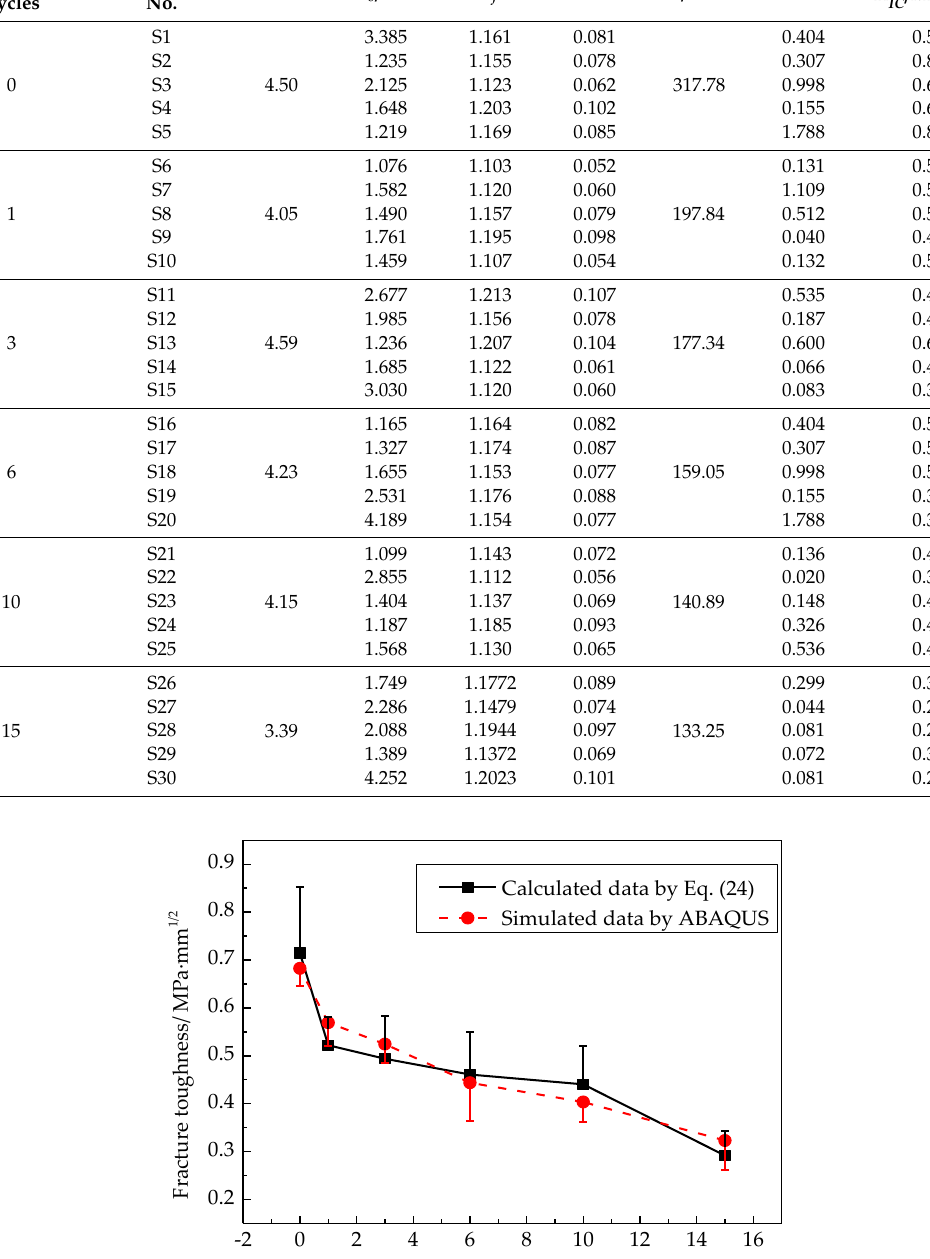
Figure 23. The comparison of calculated data and tested